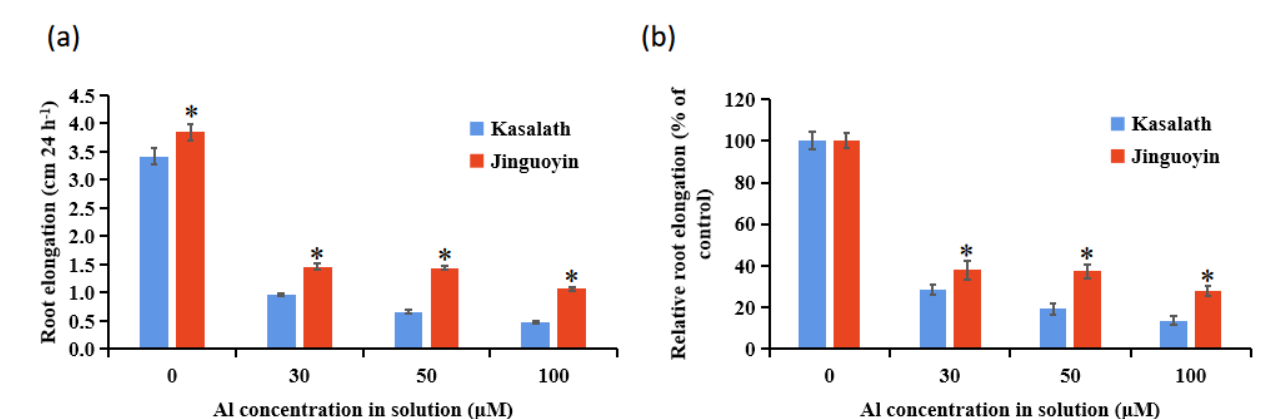
Figure 1. Al-dependent root elongation in two indica rice cultivars. ( a ) Absolute root elongation; ( b ) relative root elongation (RRE). Four-day-old seedlings of both Kasalath and Jinguoyin were exposed to a 0.5 mM CaCl 2 (pH 4.5) solution containing 0, 30, 50, or 100 μM Al for 24 h. Root lengths were measured with a ruler before and after treatment and RRE was calculated as the ratio of root elongation with Al to root elongation without Al. Data are mean ± SD (n = 10). Asterisks (*) indicate significant differences between Kasalath and Jinguoyin at each Al concentration at p -values <0.05 by the Student’s t -test.